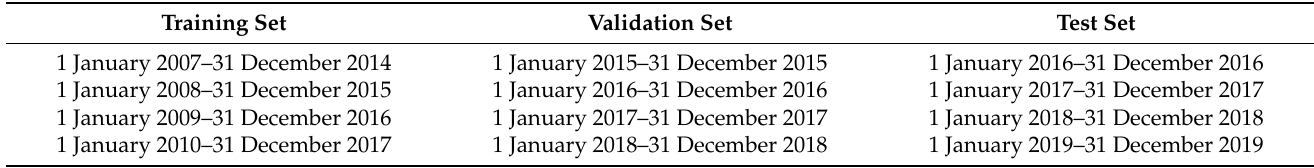
Table 1. Training set, validation set, and test set for the repeatability evaluation. Training Set Validation Set Test